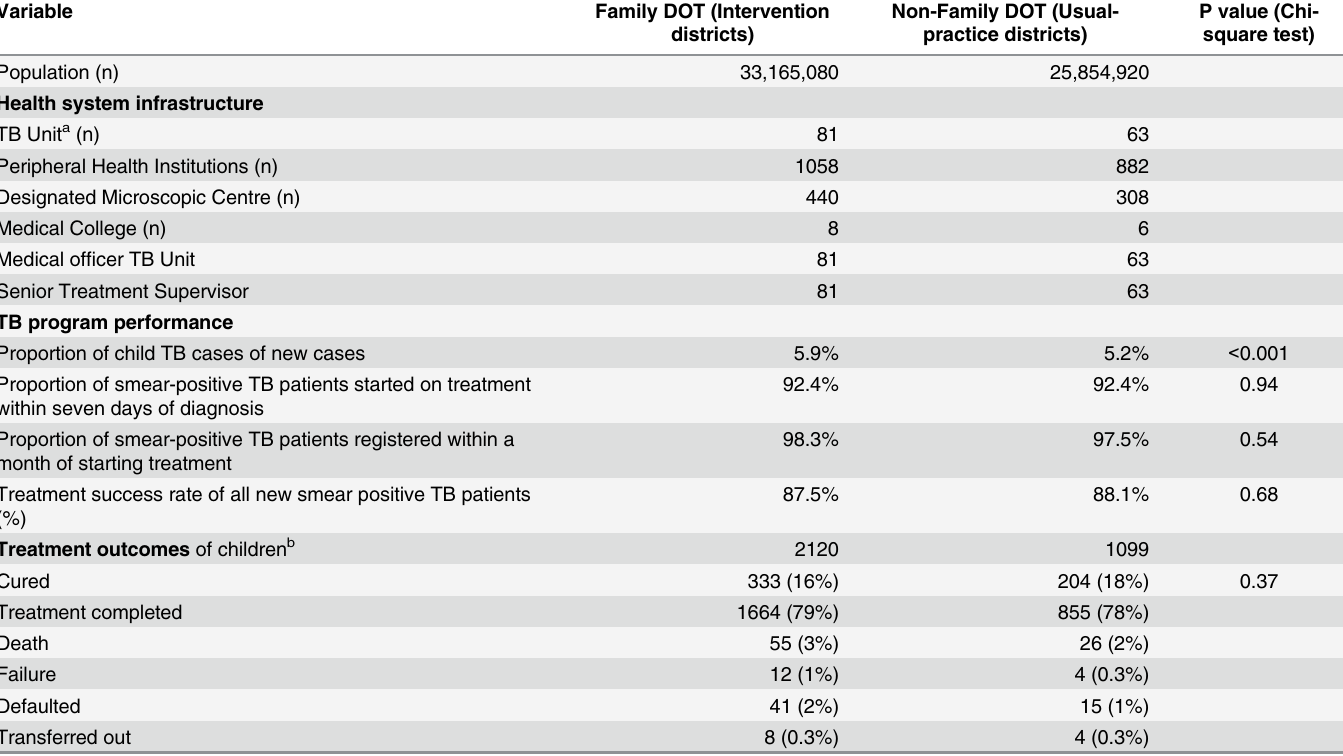
Table 1. Baseline characteristics of districts by intervention, year 2011